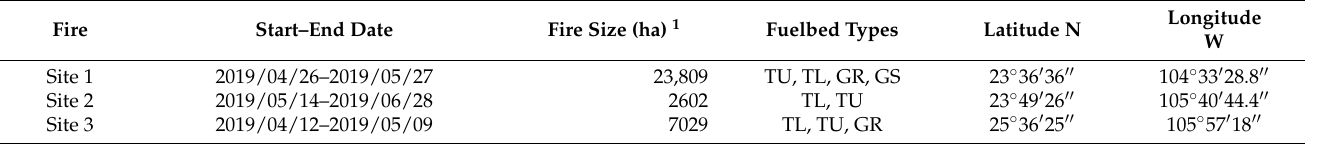
Table 1. Summary of wildfires selected in the Sierra Madre Occidental, Durango.